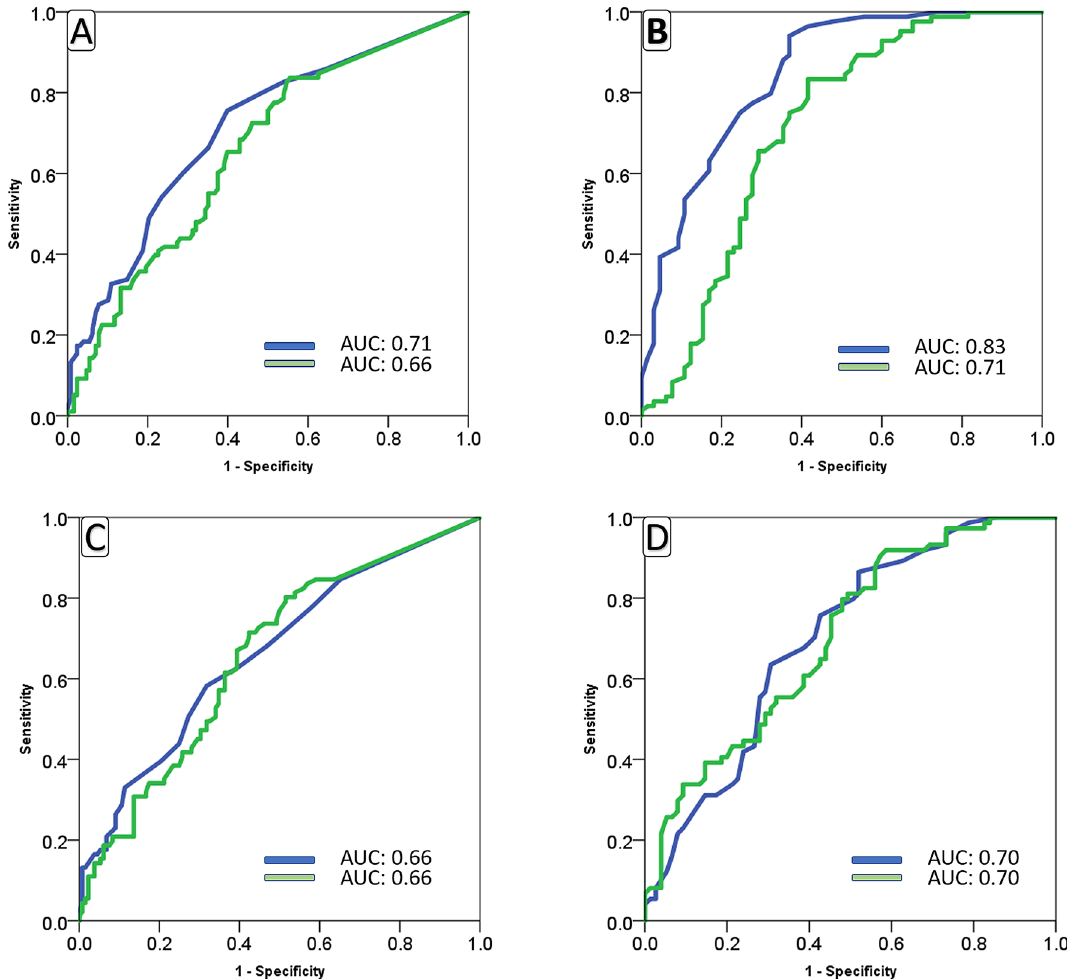
Figure 2. Area under the curve for baseline ( A , C ) and maximum ( B , D ) RALE (blue) and AI (green) scores in Site A patients with different outcomes ( A , B ) of COVID-19 infection and need for mechanical ventilation ( C , D